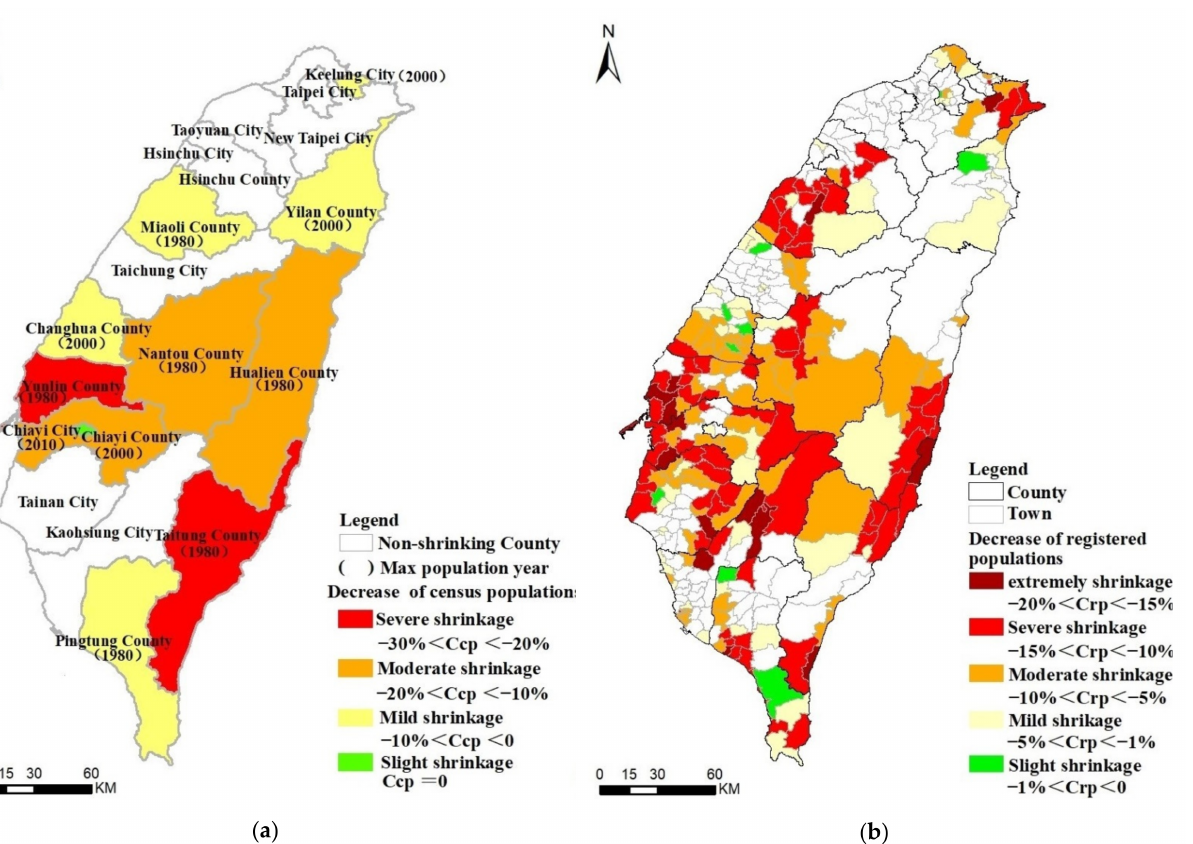
Figure 4. Classification of shrinkage: ( a ) decrease in census population of shrinking counties; ( b ) decrease in registered population of shrinking